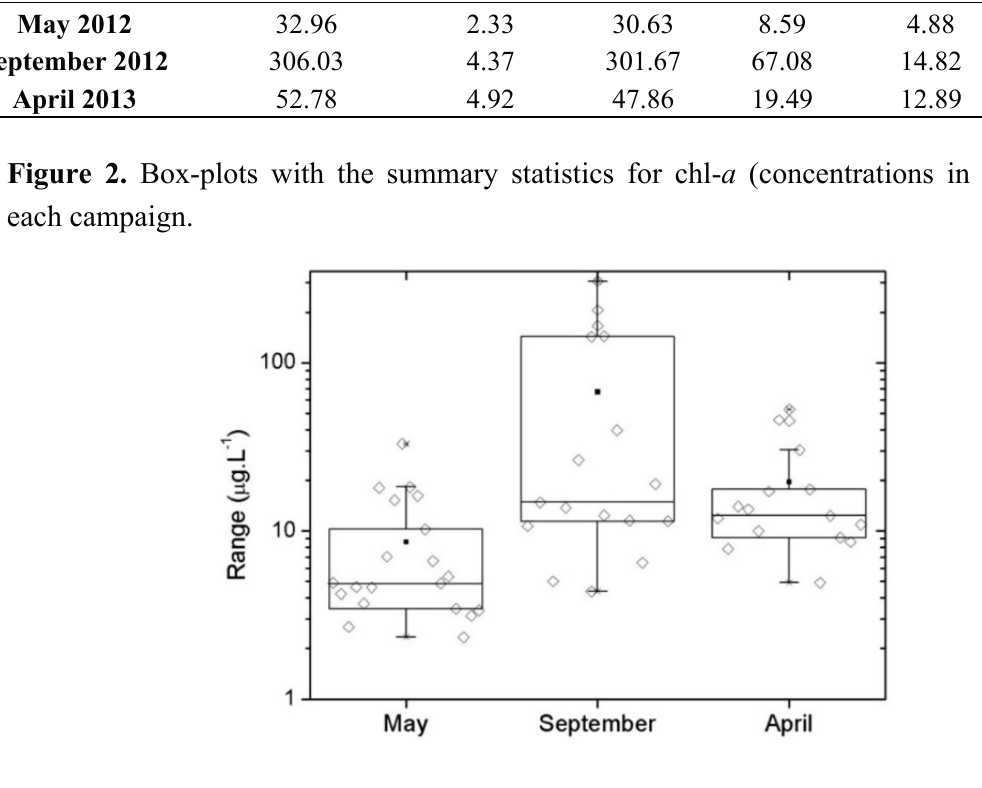
Standard Deviation